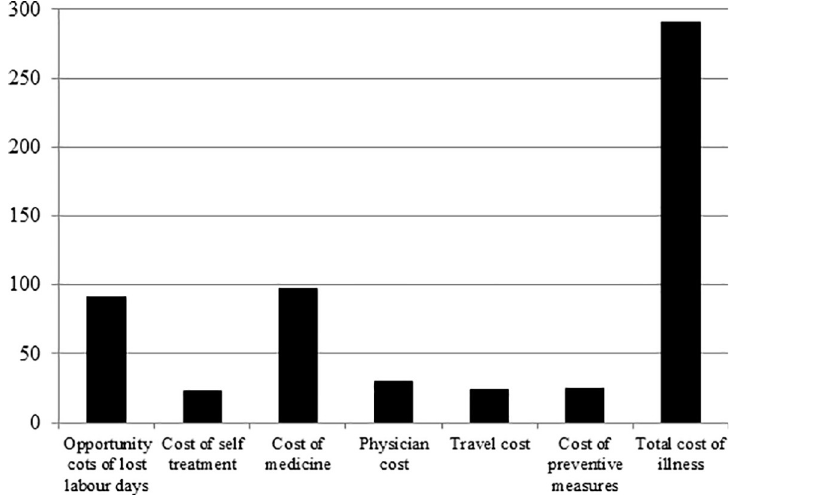
Fig 1. Composition of average cost of illness reported by farmers (in